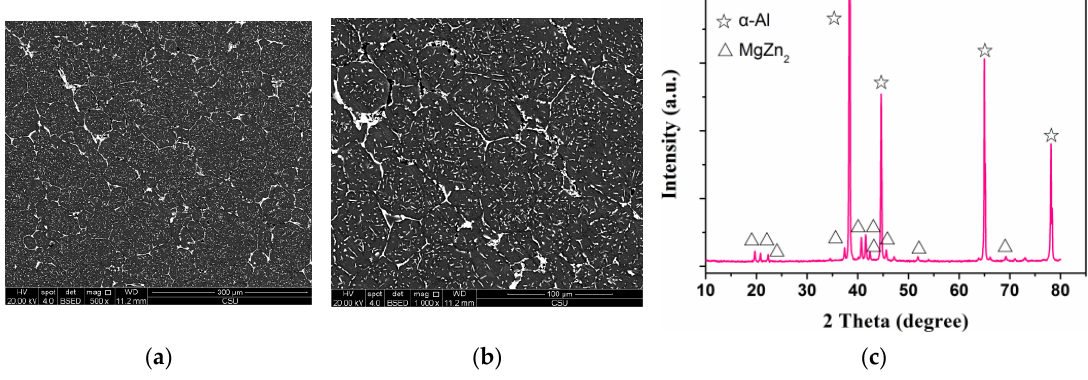
Figure 1. Back-scattered electrons images ( a , b ) and XRD (X-ray diffraction) pattern ( c ) of as-spray-deposited Al-8.31Zn-2.07Mg-2.46Cu-0.12Zr alloy.